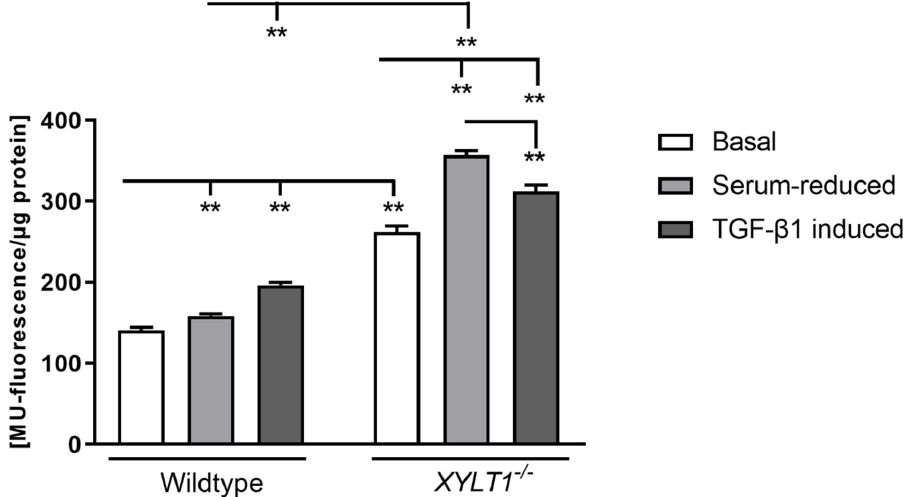
Figure 7. Quantification of the cellular-senescence of WT- and XYLT1 − / − fibroblasts. Wildtype and XYLT1 − / − fibroblasts were seeded (50 cells/mm 2 ) and incubated overnight. After 24 h, cells were further cultivated under standard cell-culture conditions (10% FCS) or a serum withdrawal from 10% to 0.1% FCS was performed for 24 h. Thereafter, cells were incubated with a vehicle (negative control) or TGF- β 1 (5 ng/mL) for another 72 h. Cells were lysed, centrifuged and super- natant was subsequently mixed with a reaction buffer, containing 1.7 mM 4-Methylumbelliferyl β - D- galactopyranoside (MUG). Spectrophotometrically measurements were conducted by using Tecan Reader Infinite 200 PRO (excitation: 360 nm, emission: 465 nm, integration: 40 µ s). Values represent means ± SEM. ** p <